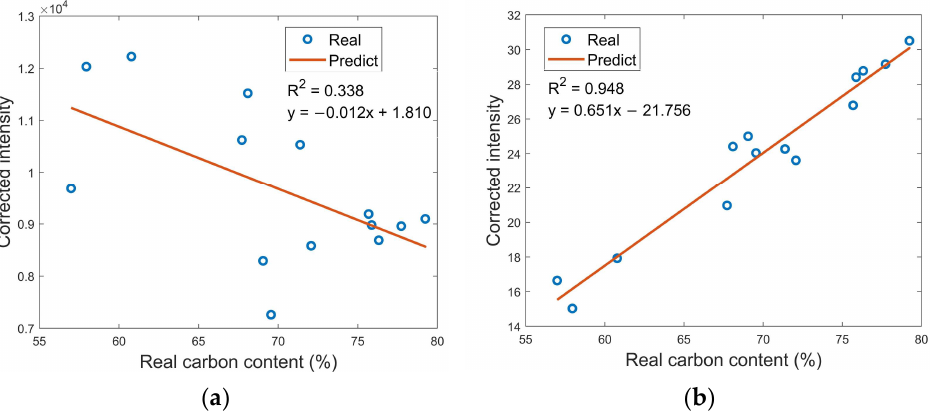
Figure 7. Plot of the fitting effect of C193.045 nm after P-airPLS method. The goodness of fit for C193.045 nm improved from being nonlinear to linear with the value of 0.948. ( a ) The goodness of fit for original data; ( b ) goodness of fit for processed data.